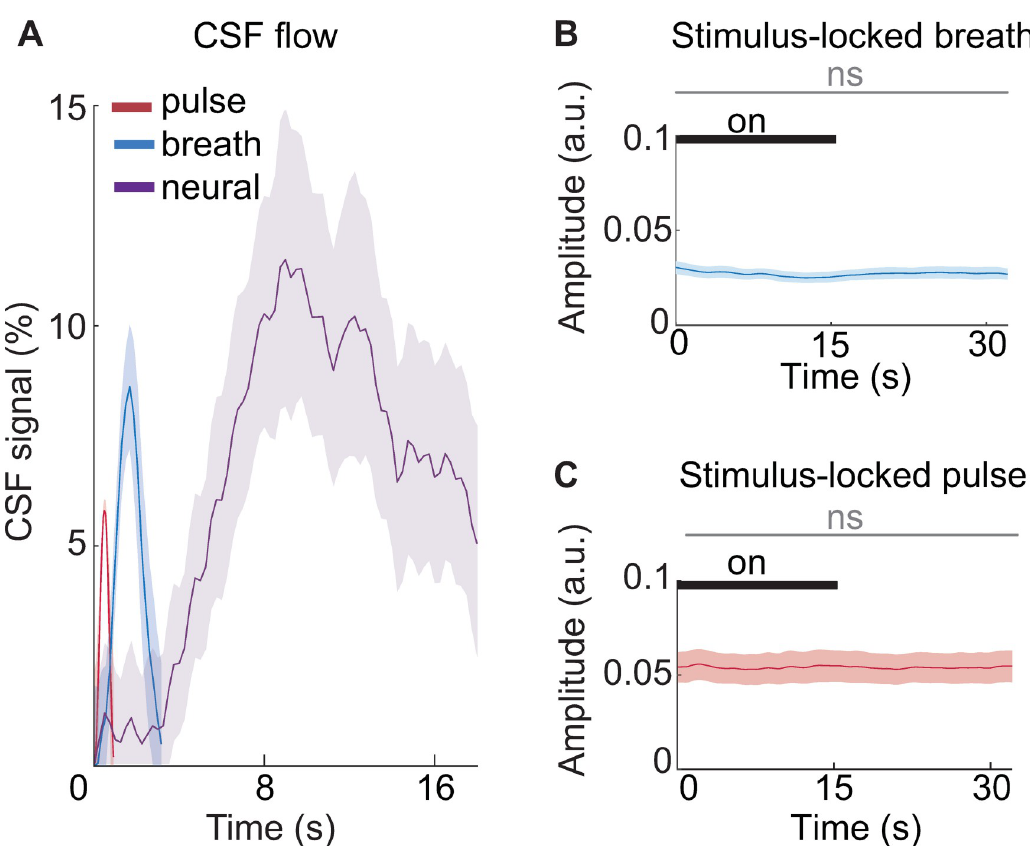
Fig 4. Neurally driven CSF flow signals during the visual task have comparable magnitude to flow signals driven by systemic physiology. ( A ) Average CSF flow locked to breath cycle (blue), cardiac cycle (red), and visual stimulus offset (purple), with no temporal smoothing. The breath and cardiac cycles were scaled by the average length of a single cycle (average breath cycle length = 3.16 s; average cardiac cycle length = 0.9 s). Shading is standard error across subjects ( n = 16). ( B) The average amplitude envelope of the respiration signal shows no significant change linked to the visual stimulus. Shading indicates standard error across subjects ( n = 16). ( C ) The average amplitude envelope of the pulse oximeter signal shows no significant change locked to the stimulus. Shading indicates standard error across subjects ( n = 16). The gray bar indicates that variations in the signal amplitude between stimulus on and off blocks were not statistically significant. Data from: doi:10.18112/openneuro.ds004493.v1. 0.0. CSF, cerebrospinal